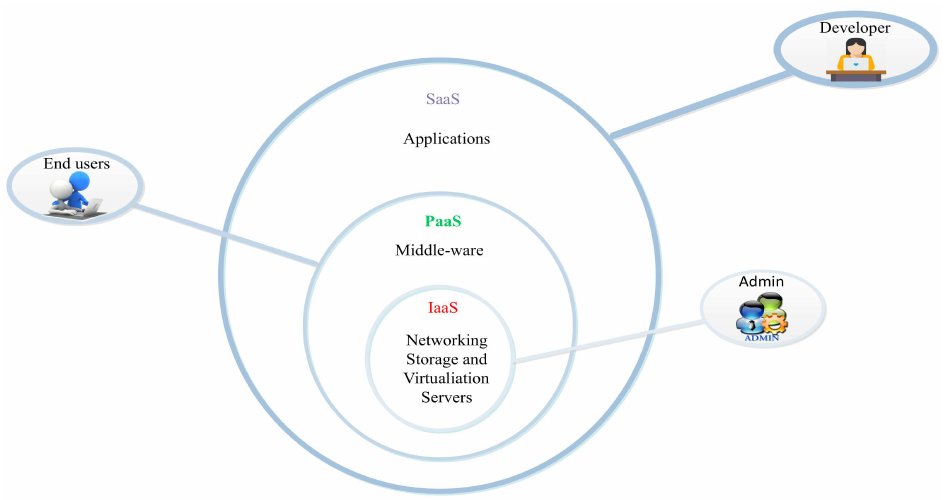
Figure 1. Cloud services.